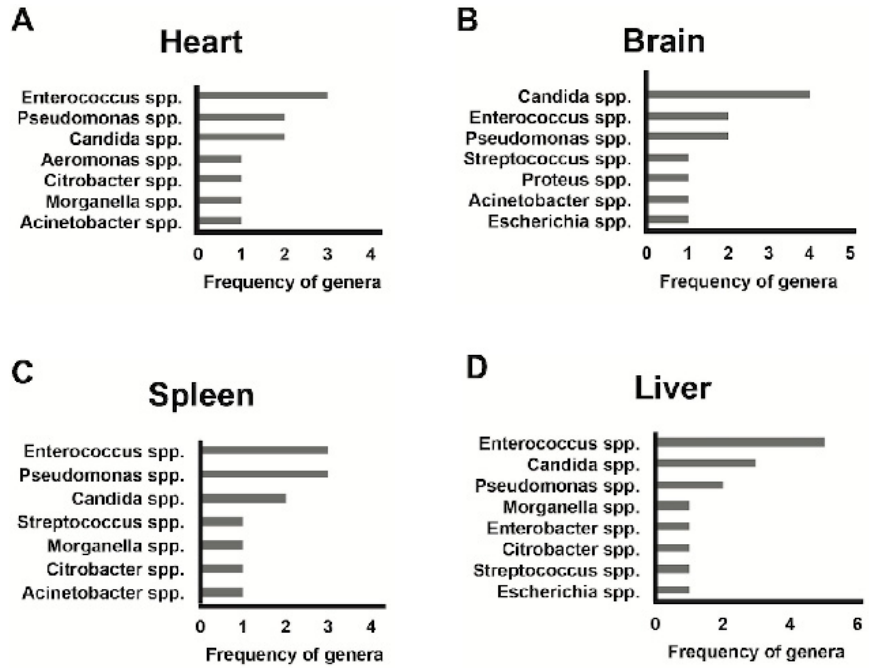
Figure 2. The distribution of genera among the four internal anatomical sites: ( A ) heart; ( B ) brain; ( C ) spleen and ( D ) liver.